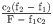
A. Fluorescence emission spectra of Tf-amox-FNH2, R1 and R1 in the presence of Tf-amox-FNH2
after subtraction of the emission contribution of the solvent. Values reported for an excitation wavelength λex of 496 nm and an emission wavelength λem of 523 nm in the presence of 10 mM CHAPS with c0 = 2 × 10−7 M and c1 = 1 × 10−7 M at 37 ± 0.1°C, μ = 0.2 and pH = 7.40. B. Plot of c2(f2 – f1)F – f1c2
against 1/[R]; slope, 7.9 ± 0.2 M with c0 = 2 × 10−7 M and 0 ≤ c1 ≤ 1 × 10−7 M and c2=c15, [CHAPS] = 10 mM, and μ = 0.2 at 37 ± 0.1°C.